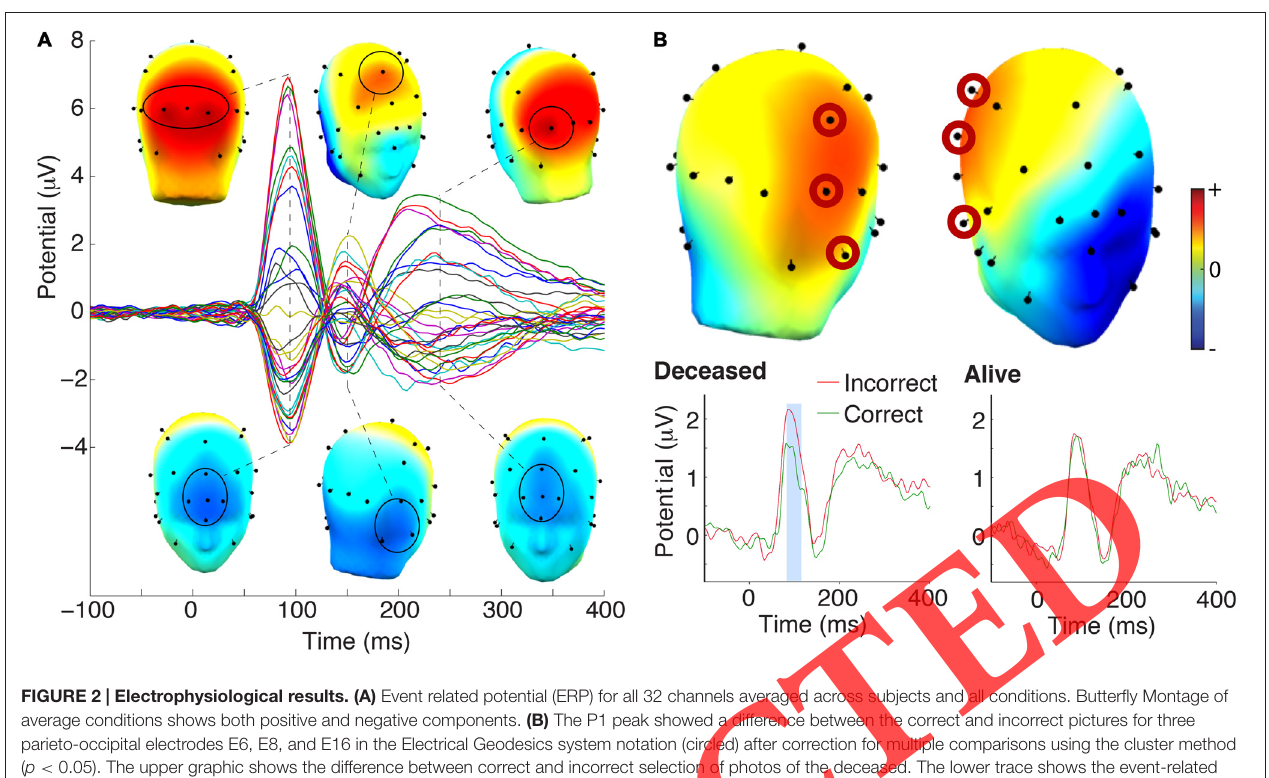
FIGURE 2 | Electrophysiological results. (A) Event related potential (ERP) for all 32 channels averaged across subjects and all conditions. Butterfly Montage of average conditions shows both positive and negative components. (B) The P1 peak showed a difference between the correct and incorrect pictures for three parieto-occipital electrodes E6, E8, and E16 in the Electrical Geodesics system notation (circled) after correction for multiple comparisons using the cluster method ( p < 0.05). The upper graphic shows the difference between correct and incorrect selection of photos of the deceased. The lower trace shows the event-related potential for correct and incorrect selections of deceased and alive photos for the average of electrodes E6, E8, and E16. The shaded blue region shows the region of significance at p < 0.05 after correction for multiple comparisons using the cluster